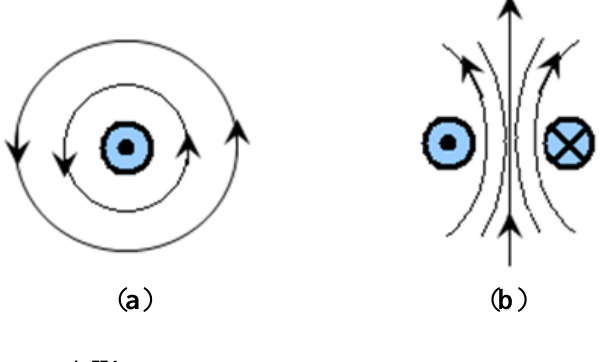
Figure 2. Magnetic fields of single and double conductors carrying current. ( a ) Single conductor; ( b ) Double